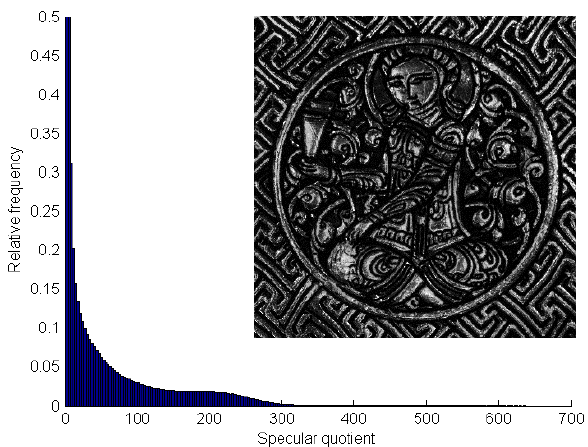
Figure 12. Image and histogram of specular quotient values.